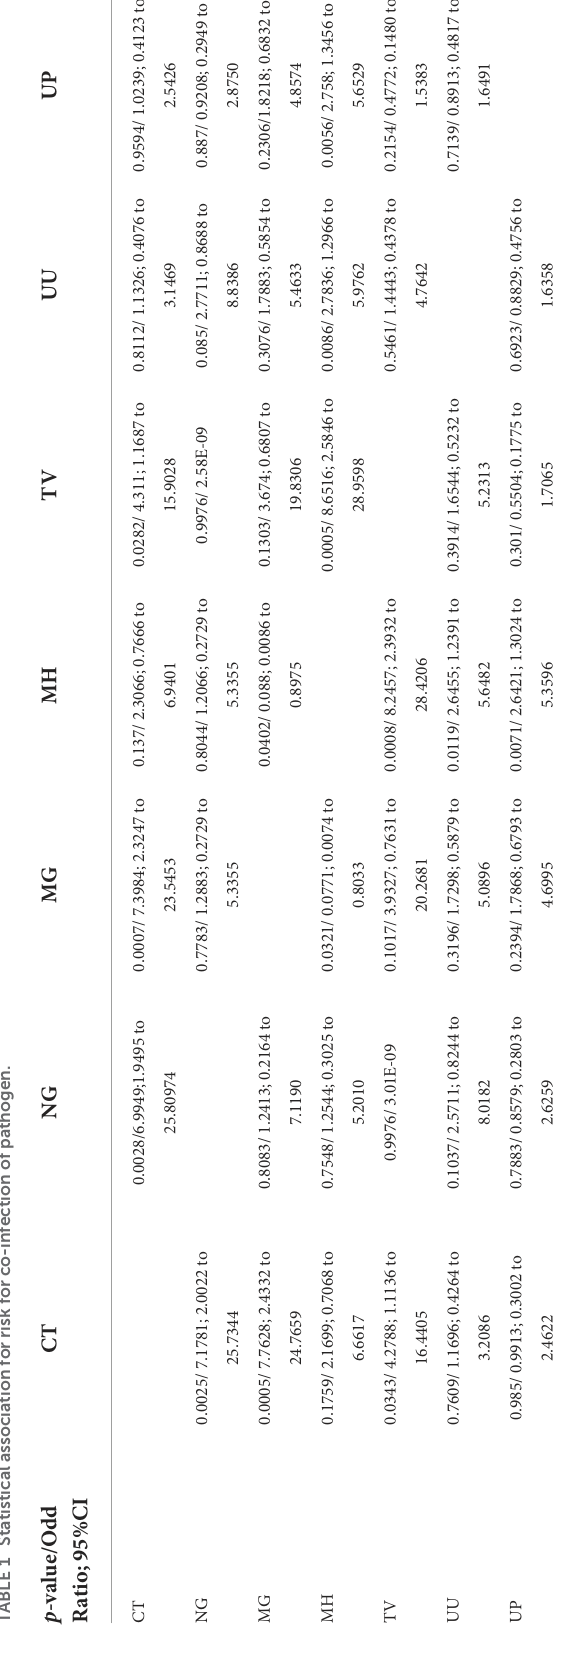
FIGURE4 Pathogen significantly causes the co-infection inter-relationship (type 1 pathogen increase the risk of infection with other pathogen).